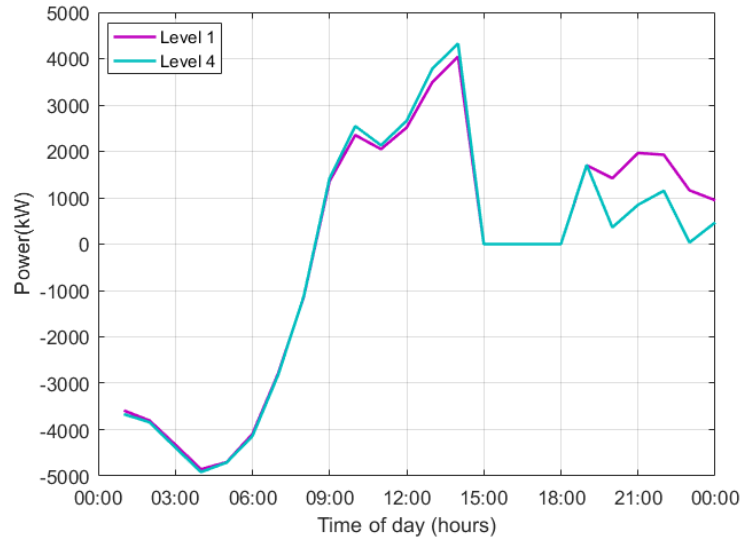
Figure 21. Active power exchanged between the microgrid and the active distribution network (op ‐ timization levels 1 and 4).